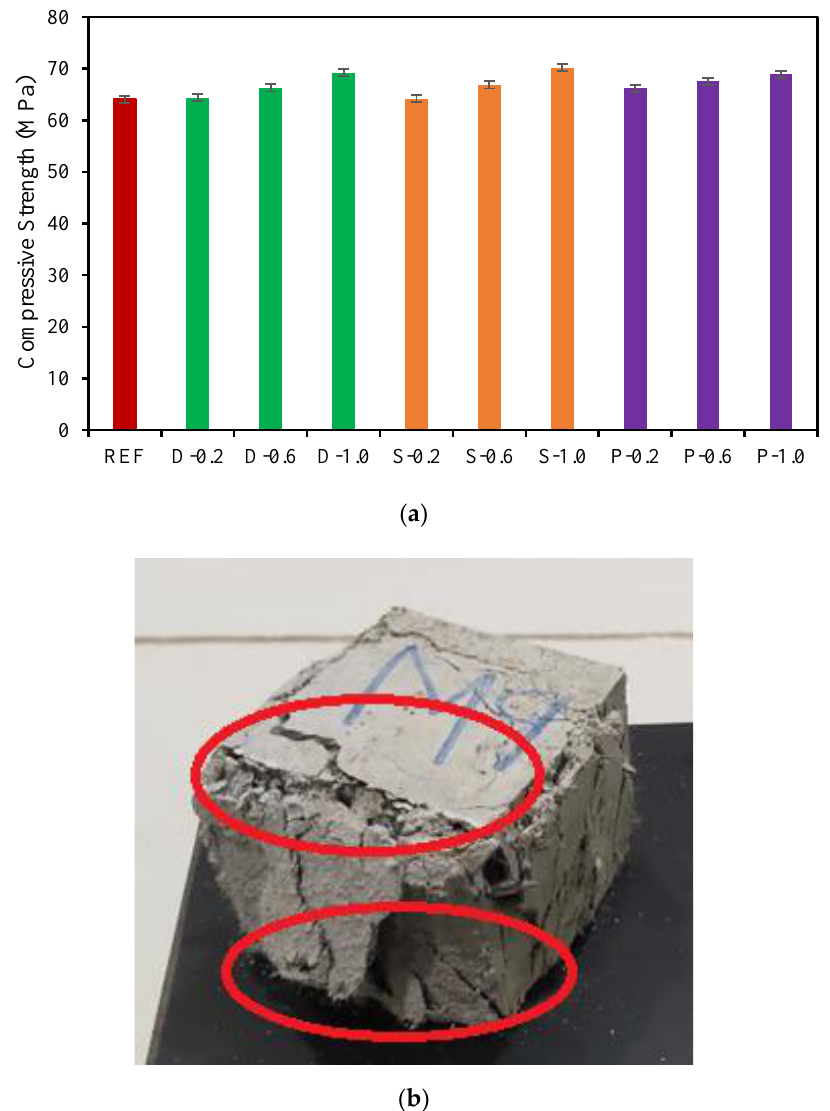
Figure 4. ( a ) Compressive strength of fibrous-reinforced high-strength concrete.; ( b ) Ductile failure of samples in compression. Read circles identify first cracking zones, indicating the ductile behav- ior.